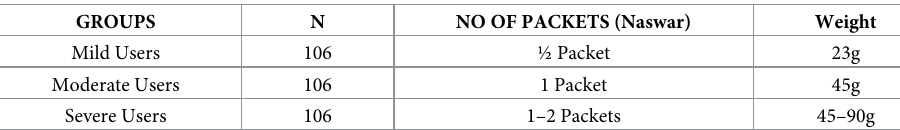
Table 1. Groups of naswar